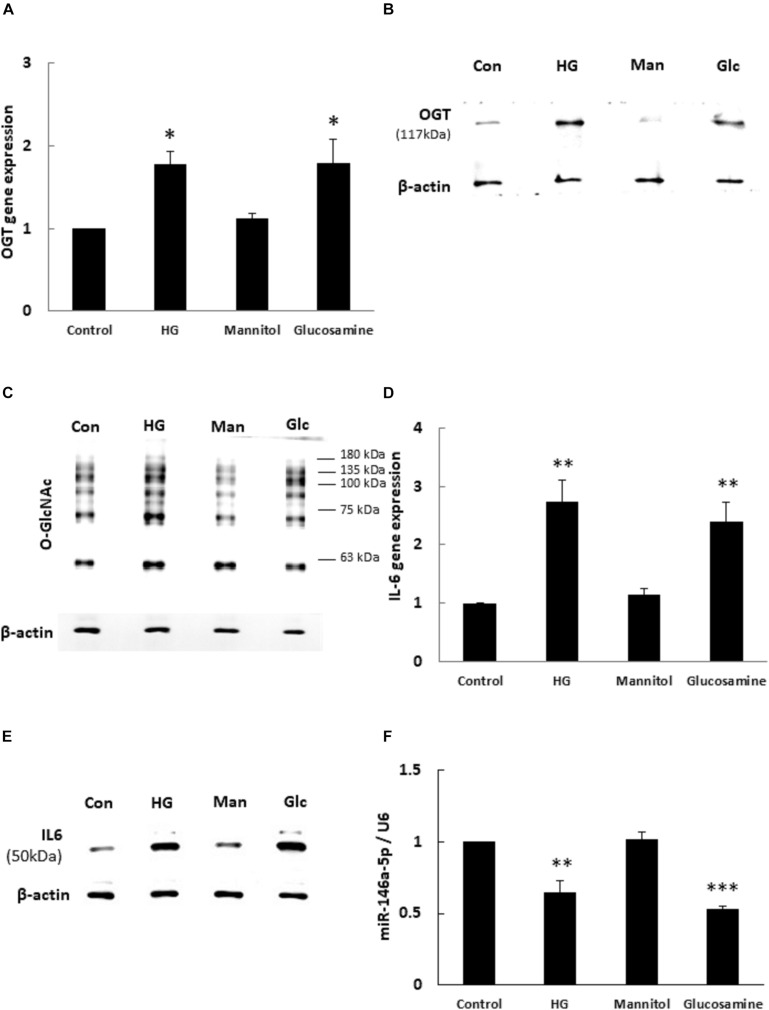
(A–F) High glucose (HG) and glucosamine (Glc) increased OGT/protein O-GlcNAcylation/IL-6 expression and decreased miR-146a expression. (A) HAECs were stimulated with HG (25 mM) and glucosamine (25 mM) for 24 h. Real-time PCR revealed that HG and glucosamine stimulation induced 1.77- and 1.79-fold increases, respectively, in OGT mRNA levels. Mannitol (25 mM) did not modulate OGT mRNA levels. N = 5. *p < 0.05 compared to control. (B,C) Stimulation of HAECs with HG and glucosamine for 24 h induced a significant increase in OGT protein and protein O-GlcNAcylation (as detected by RL2 antibody) expression. The blot is representative of three independent experiments. (D) Stimulation of HAECs with HG and glucosamine for 24 h induced 2.73- and 2.39-fold increases in IL-6 mRNA levels. N = 5. **p < 0.01 compared to control. (E) Stimulation of HAECs with HG and glucosamine for 24 h induced a significant increase in IL-6 expression. The blot is representative of three independent experiments. (F) Real-time PCR showed that HG and glucosamine stimulation for 24 h decreased miR-146a-5p expression levels to 65 and 53% of the control level, respectively. Mannitol did not modulate miR-146a-5p expression levels. miR expression levels were normalized to U6 expression. N = 3. **p < 0.01 compared with control. ***p < 0.001 compared with control.